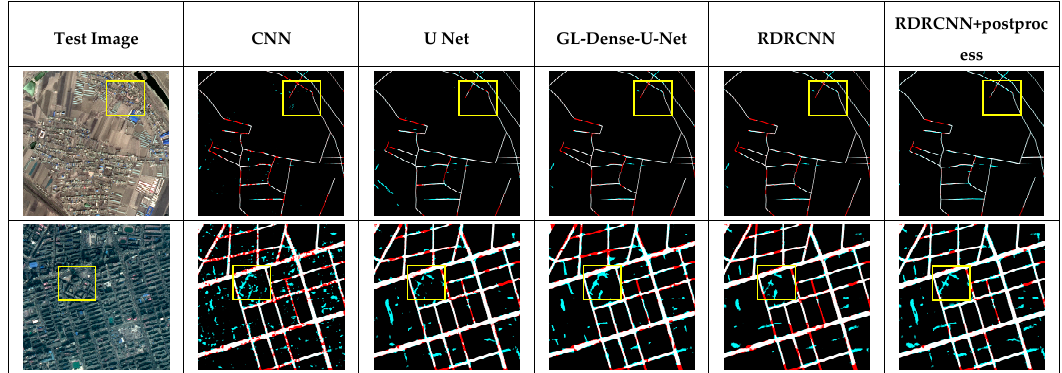
Figure 10. Comparison of the road extraction results of four methods in different experimental areas of the GF-2 dataset. Table 6. Comparisons of the proposed and other deep-learning-based road extraction methods on the Massachusetts road test dataset in terms of better performance of testing.